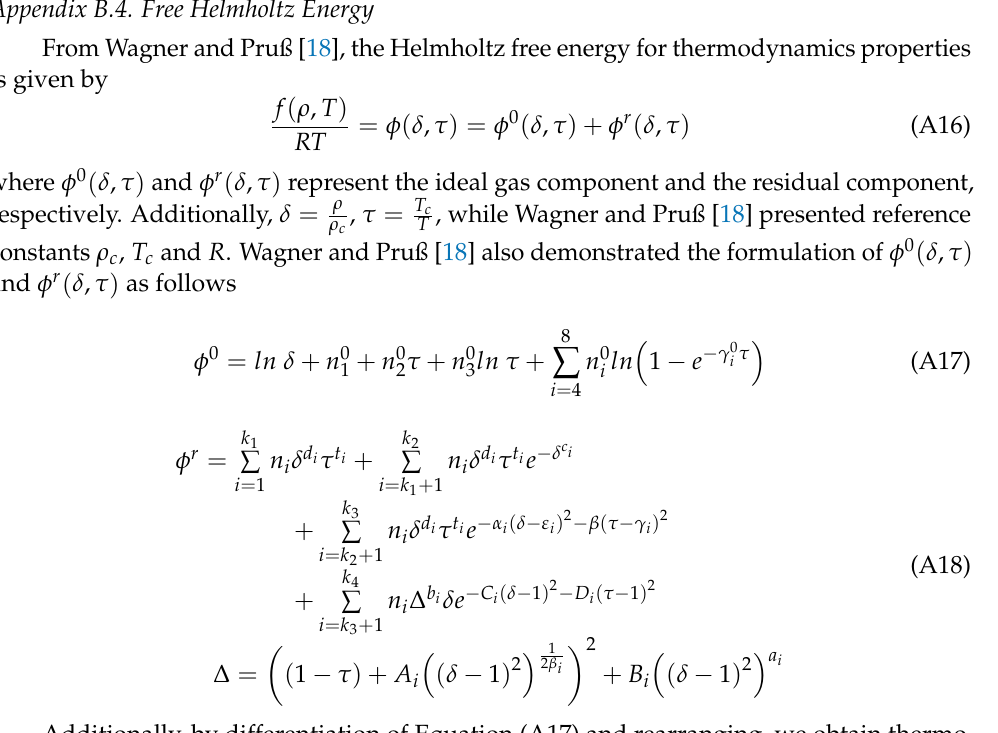
Table A2. Relationship of thermodynamics functions to the Helmholtz free energy and their derivatives. Thermodynamic Function Relation Pressure